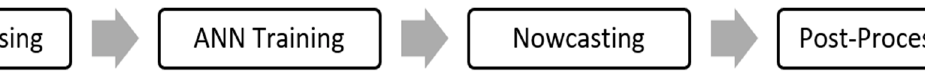
Figure 2. The process flow of the proposed prediction model.